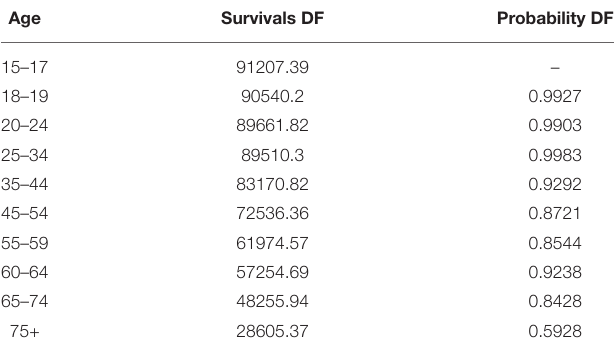
TABLE 4 | Disability-free survival probability.